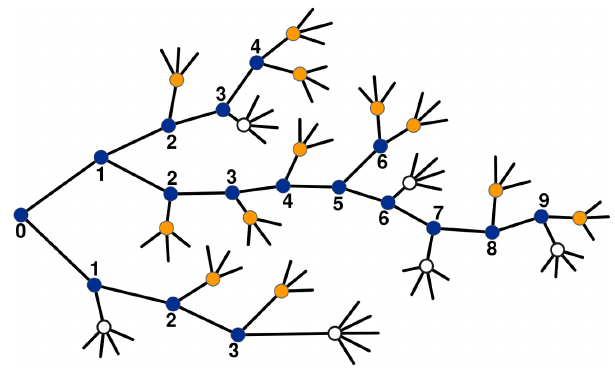
FIG. 1. A snapshot of the branching process of propagation of node pruning in a small part of the network of 10 5 nodes during the plateau stage ( h q i < h q i c ) of the k -core pruning process for k ¼ 3 . The node labeled 0 is pruned, causing the corona nodes (i.e., nodes with degree 3) labeled 1 to lose edges. These two nodes are pruned in the next step, and so on, with further corona nodes removed in subsequent steps according to the numbered order. Orange and white circles represent the nearest-neighboring nodes of degree 4 and greater than 4, respectively, that survive because their degrees exceed 3. The orange nodes after this pruning become of degree 3. They augment other corona clusters, which may then be pruned at a later